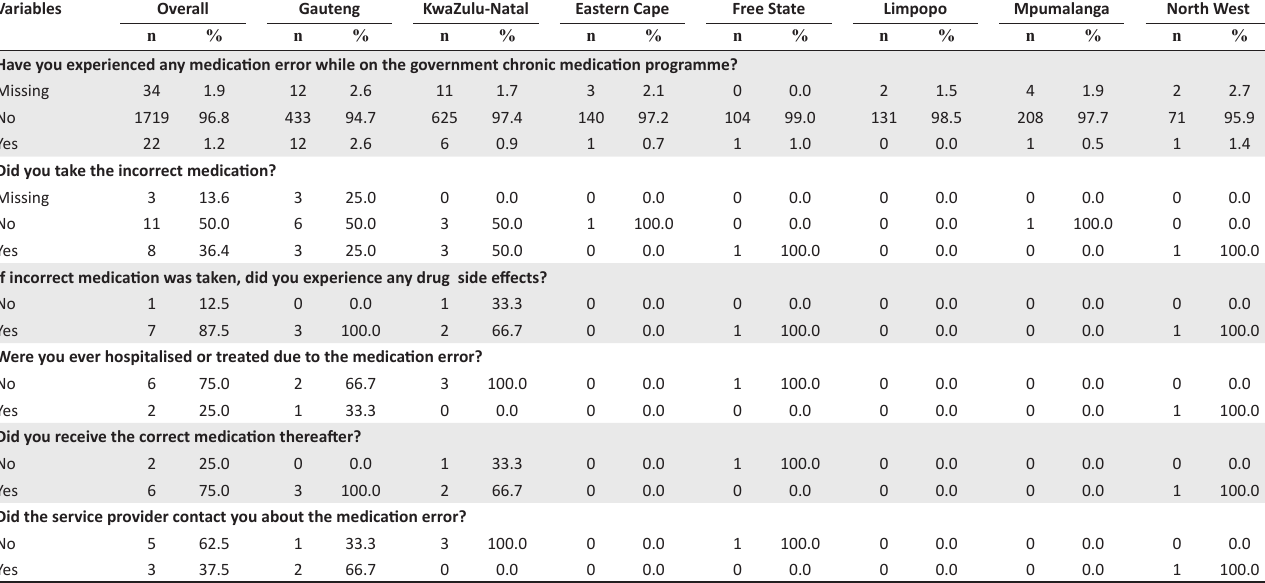
TABLE 5: Medication errors reported by patients on the tenofovir disoproxil fumarate/emtricitabine/efavirenz regimen in the survey.